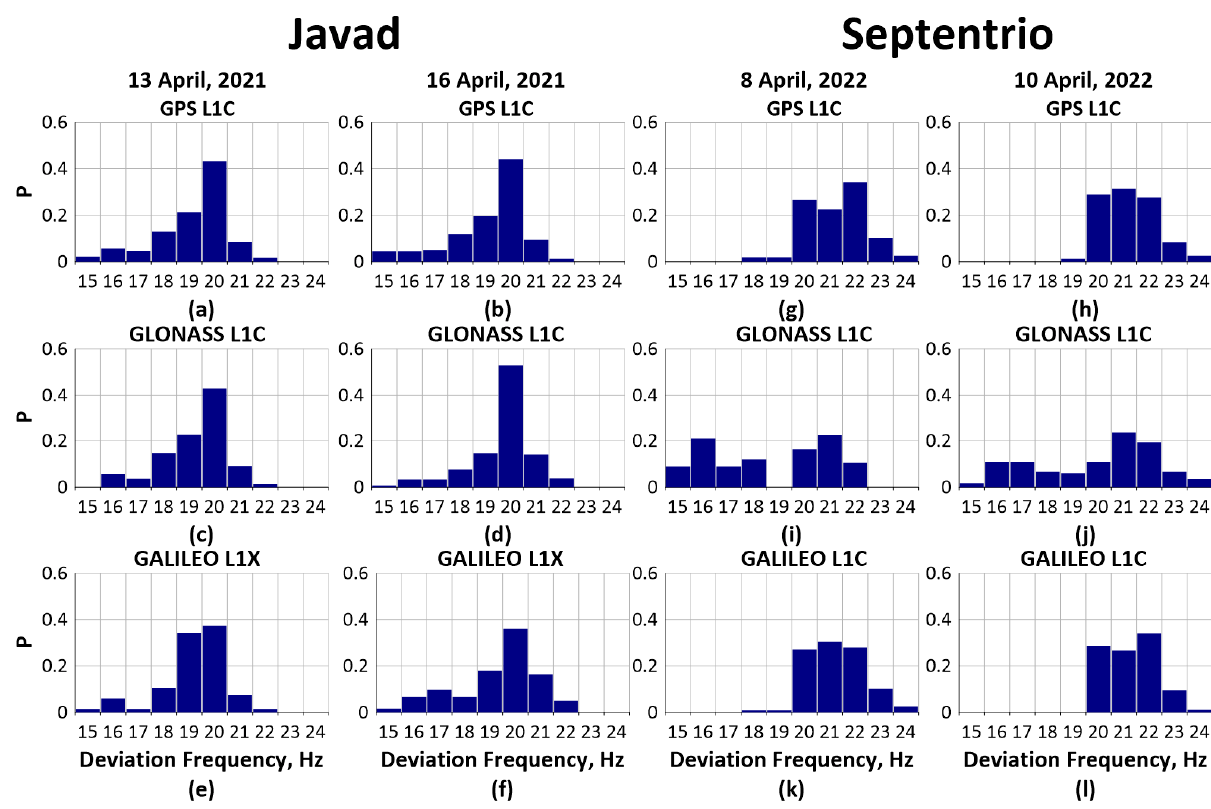
Figure 4. Distribution of the deviation frequencies obtained from 50 Hz data by Javad ( a – f ) and Septentrio ( g – l ) under different geomagnetic conditions.